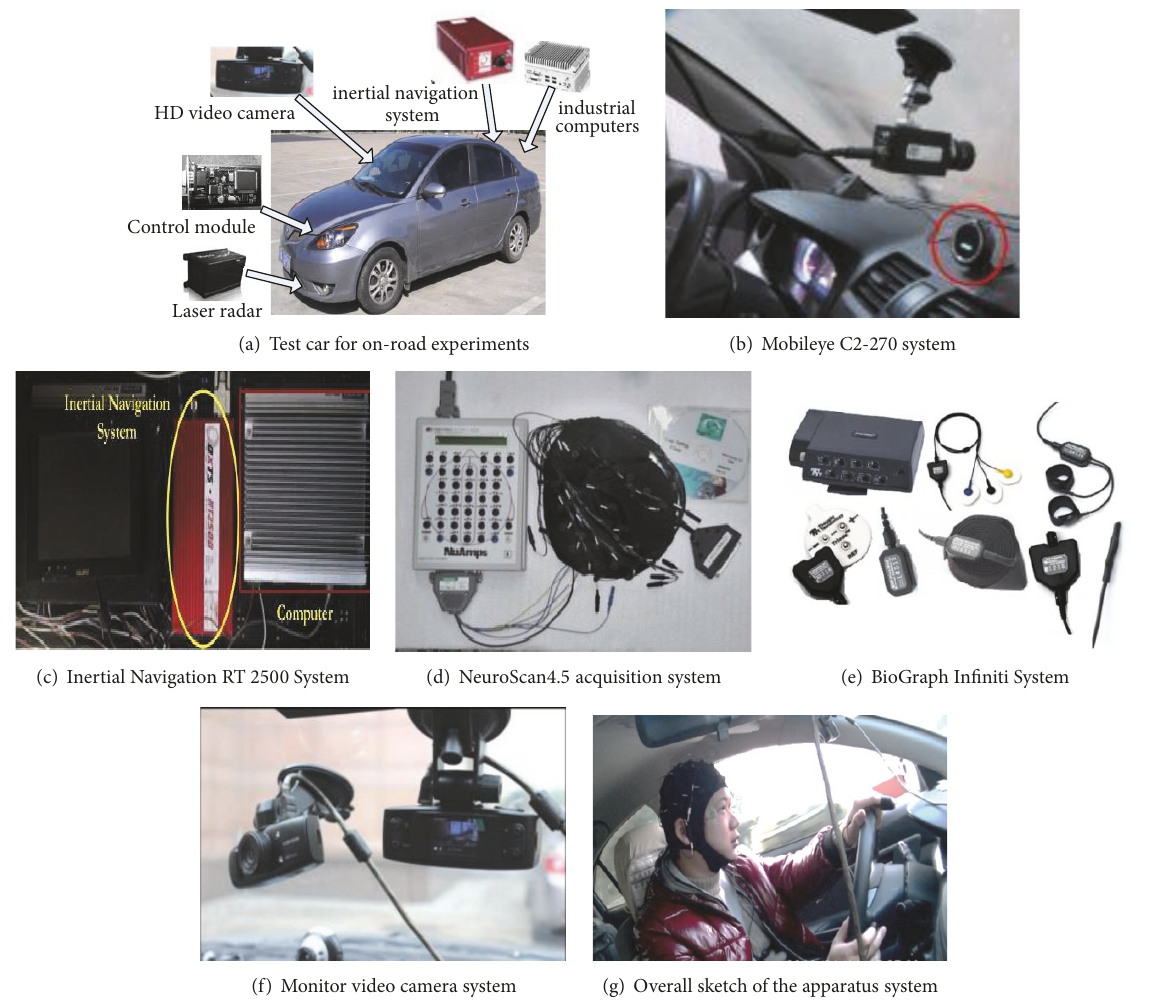
Figure 1: The Apparatus of field experimental system